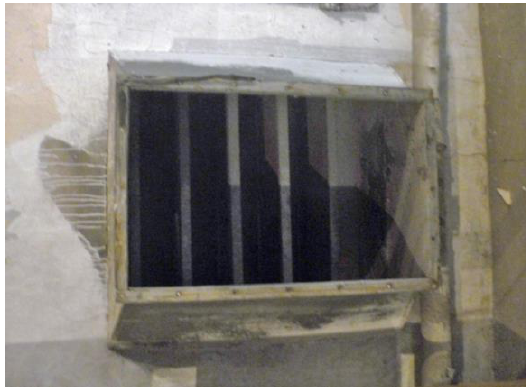
Fig. 1. Dust chamber with a filter section (own collection).